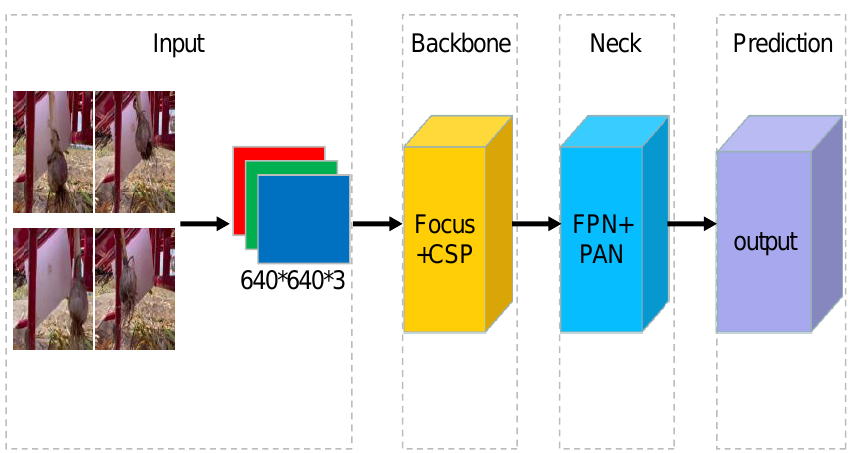
Figure 5. YOLOv5 algorithm structure diagram.